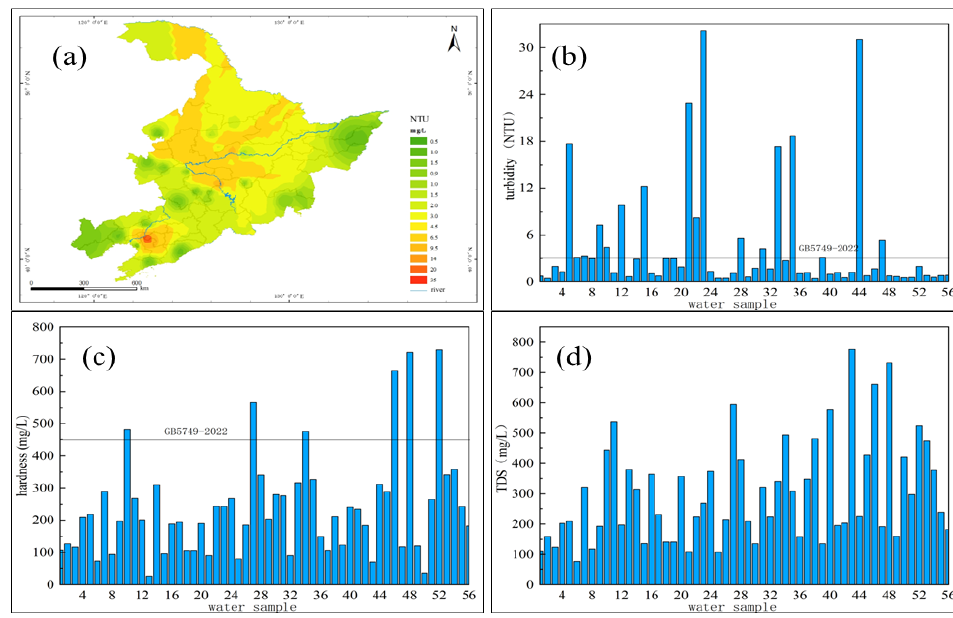
Figure 7. Distribution and concentrations of turbidity, hardness and total dissolved solids in M area. ( a , b ) turbidity ( c ) hardness ( d ) TDS. ( a , b ) turbidity ( c ) hardness ( d )